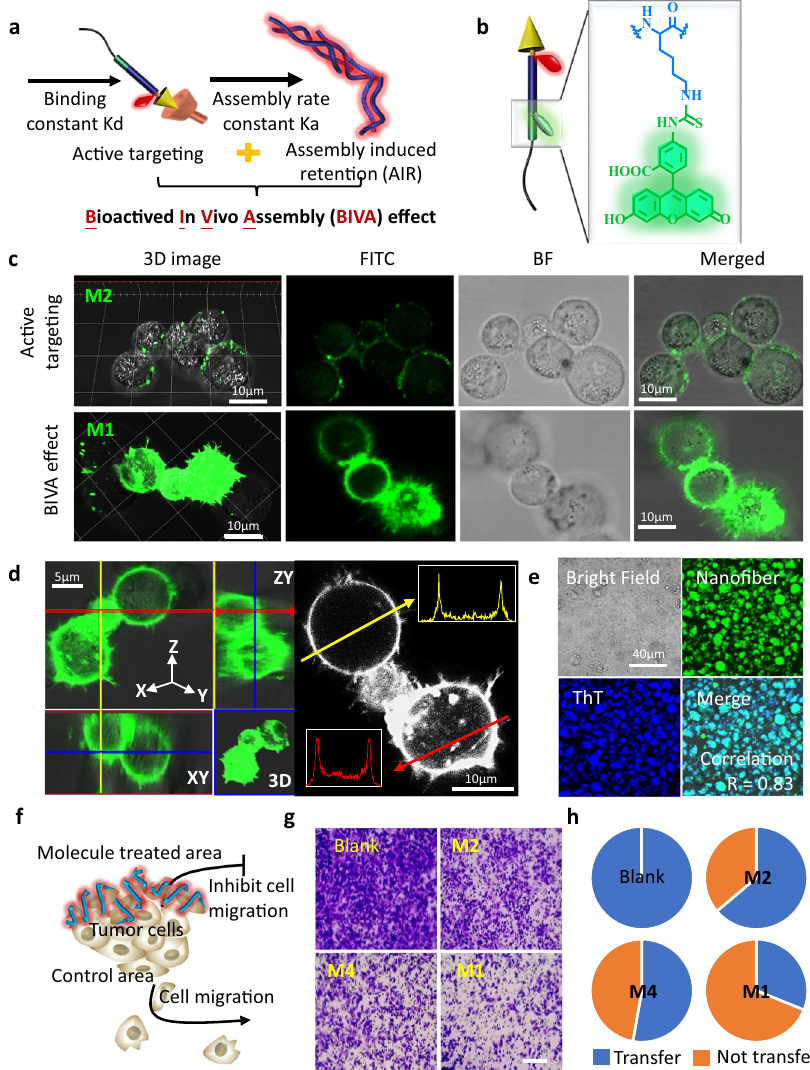
Fig. 5 The BIVA effect with enhanced targeting to pancreatic tumor cell for boundaries imaging. a Illustration of BIVA effect: active targeting and assembly/aggregate induced retention (AIR) effect. b Chemical structure of FITC labeling. c 2D and 3D confocal images of M2 with active targeting property and M1 with BIVA effect on MIA PaCa-2 cells after incubation for 1 h. d The distribution of M1 on MIA PaCa-2 cell. e ThT staining of the lysed cell membrane of MIA PaCa-2. f , Illustration of migration inhibition after treated by BIVA probe. g The image of the migrated cells after treatment of PBS (blank), M2 , M4 , and M1 . Scale bar: 100 μ m. h The pie diagram of quantitative statistical calculation of the migrated cells (blue) in different groups. The blank control was set as 100% migrated